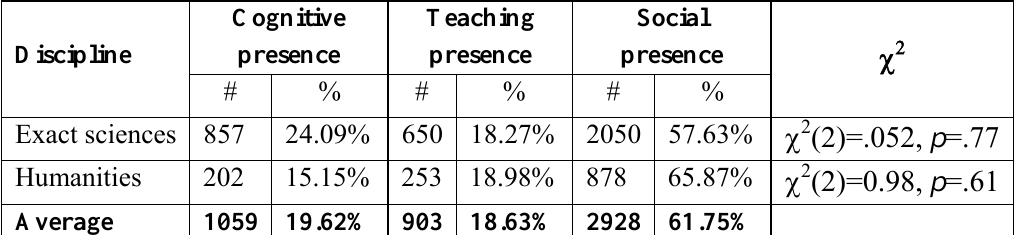
Differences between Observed Distributions by Disciplines and Proposed Population Parameter